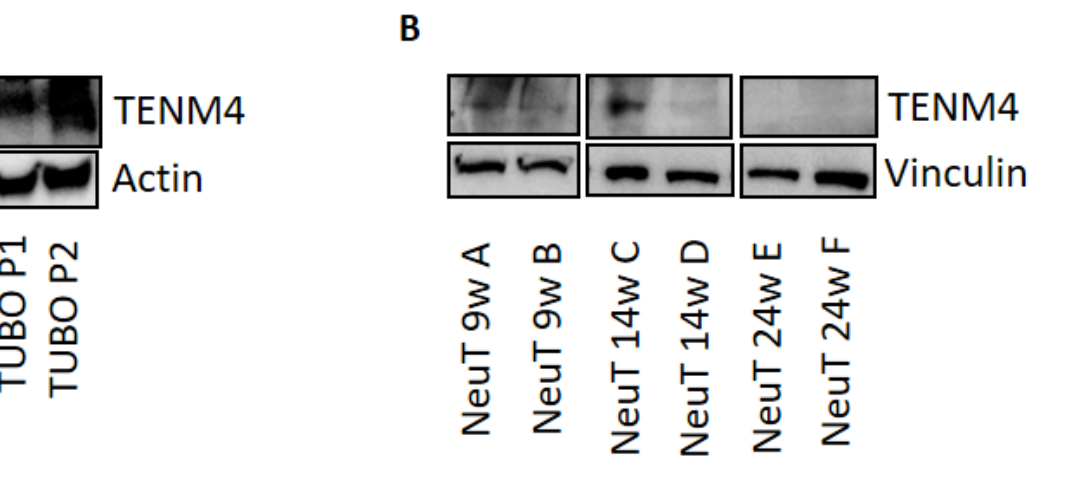
Figure 5. TENM4 expression in HER2-positive breast cancer cells and tumors: ( A ) Immunoblot of TENM4 and loading control protein (Actin) that compares HER2-positive TUBO epithelial cells (ep), first-passage tumorspheres (P1) and second-passage tumorspheres (P2). ( B ) Immunoblot of TENM4 and loading control protein (Vinculin) that compares HER2-positive mammary tumors from 9- (NeuT9wA and B), 14- (NeuT14wA and B), and 24- (NeuT24wA and B) week-old BALB-neuT mice. A total of 80 µg of TUBO cells and BALB-neuT tumor lysates were separated via electrophoresis in a 7.5% Mini-Protean TGX precast gel (Bio-Rad) and transferred onto an Immobilon-P PVDF membrane. Following blocking with 5% non-fat dry milk, the membrane was incubated with sheep anti-TENM4 (1 µ g/mL, Cat#AF6320, R&D Systems, Minneapolis, MN, USA), with mouse anti- β -Actin (1:200, Clone AC-15, Santa Cruz Biotechnology), and with mouse anti-Vinculin (1:8000, produced in-house).